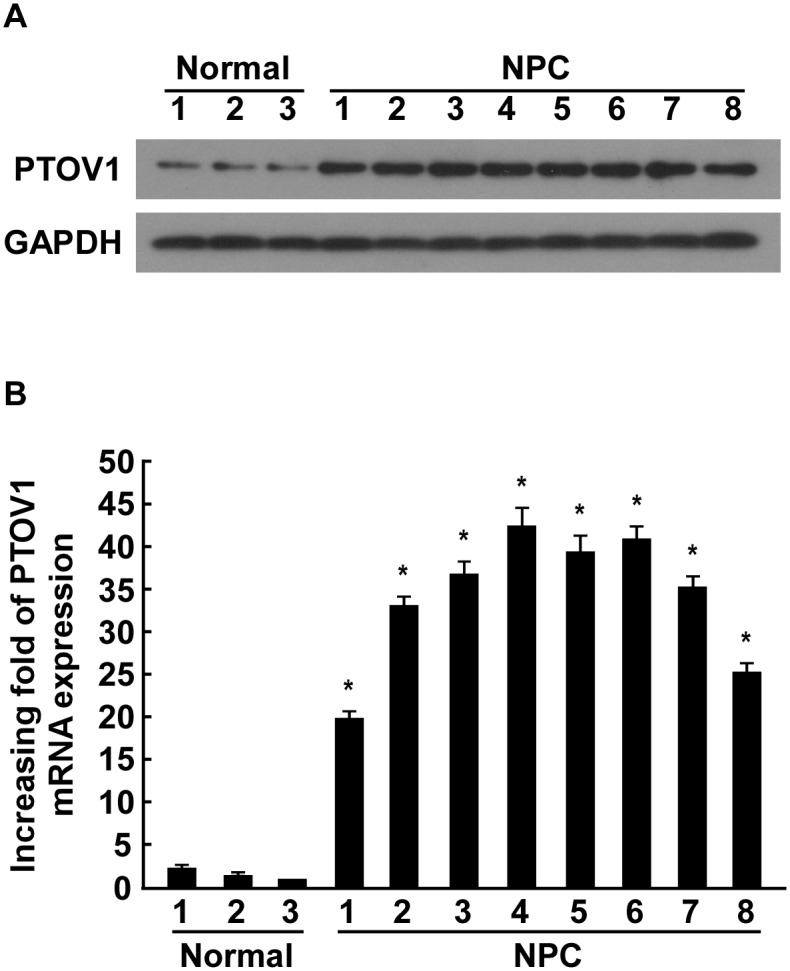
Overexpression of PTOV1 protein and mRNA in NPC tissues.(A) Expression of PTOV1 protein in three normal nasopharyngeal epithelial tissues and eight NPC tissues, measured by western blotting. GAPDH was used as a loading control. (B) Real-time PCR analysis of PTOV1 mRNA in three normal nasopharyngeal epithelial tissues and eight NPC tissues. Expression data were normalized to GAPDH. Error bars represent the SD, calculated from three parallel experiments. * P < 0.05.